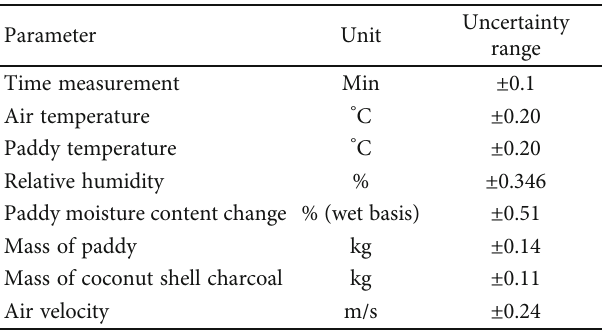
Table 6: Uncertainties of parameters during the paddy drying